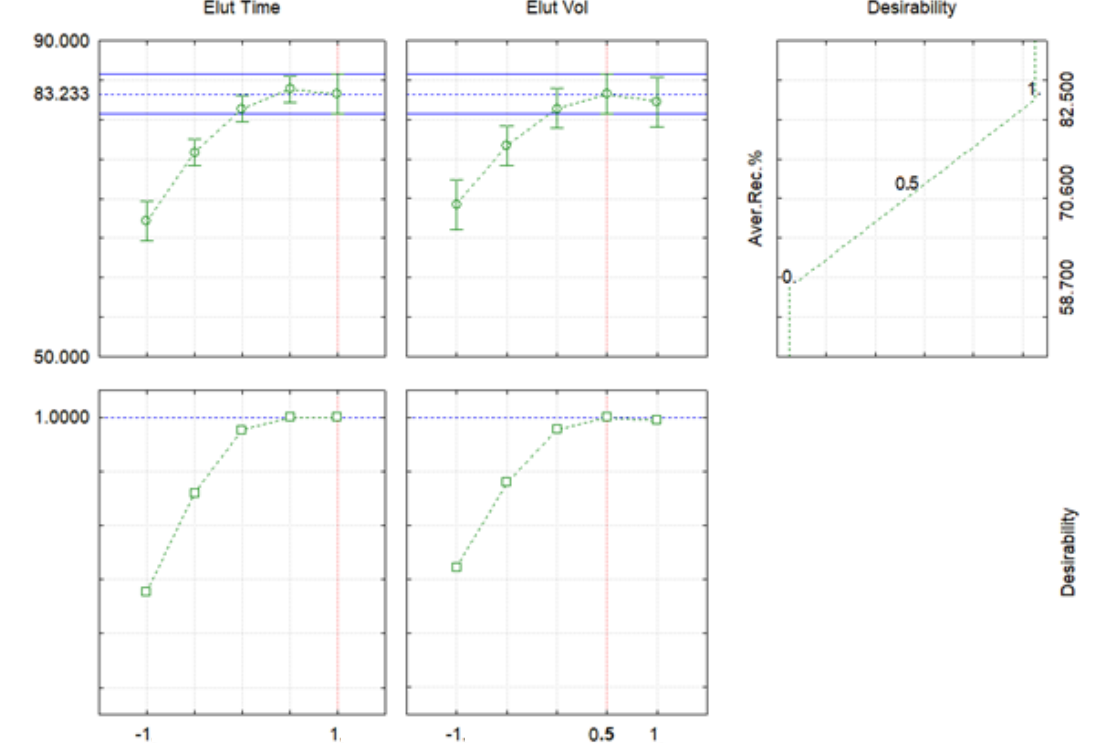
Figure 4. Desirability profiles and predict levels (coded values).